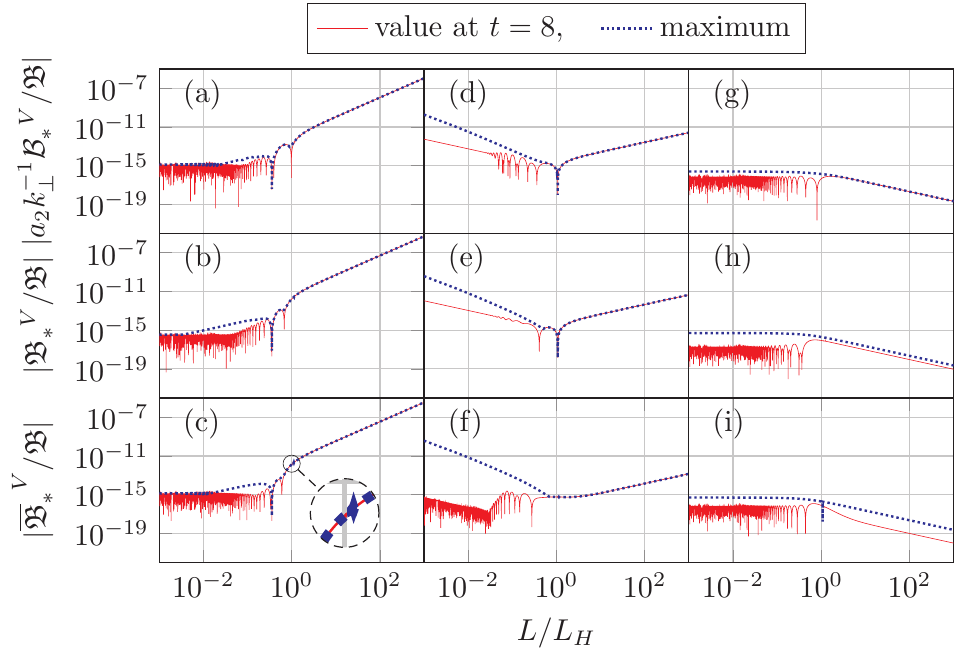
Figure 1. Generated magnetic fields as functions of perturbation length scale using the background spacetime specified in Equation (163). Both the maximum amplitude and the values extracted at the integration time t = 8 are shown. In ( a – c ), the results using the initial conditions speci- fied in Equations (165)–(167) are displayed, whilst ( d – f ) and ( g – i ) use Equations (168)–(170) and = 2 k = 2 k ( t 0 ) / √ 5, and r B = 0.1. The Equations (171)–(173), respectively. In all calculations, k ⊥ (cid:107) initial resistivity was η ( t 0 ) = 10 − 3 in ( a – f ) and η ( t 0 ) = 1 in ( g – i ). Sharp and noise-like spikes slightly above L / L H equal to unity may be due to numerical problems encountered when the auxiliary function B approaches